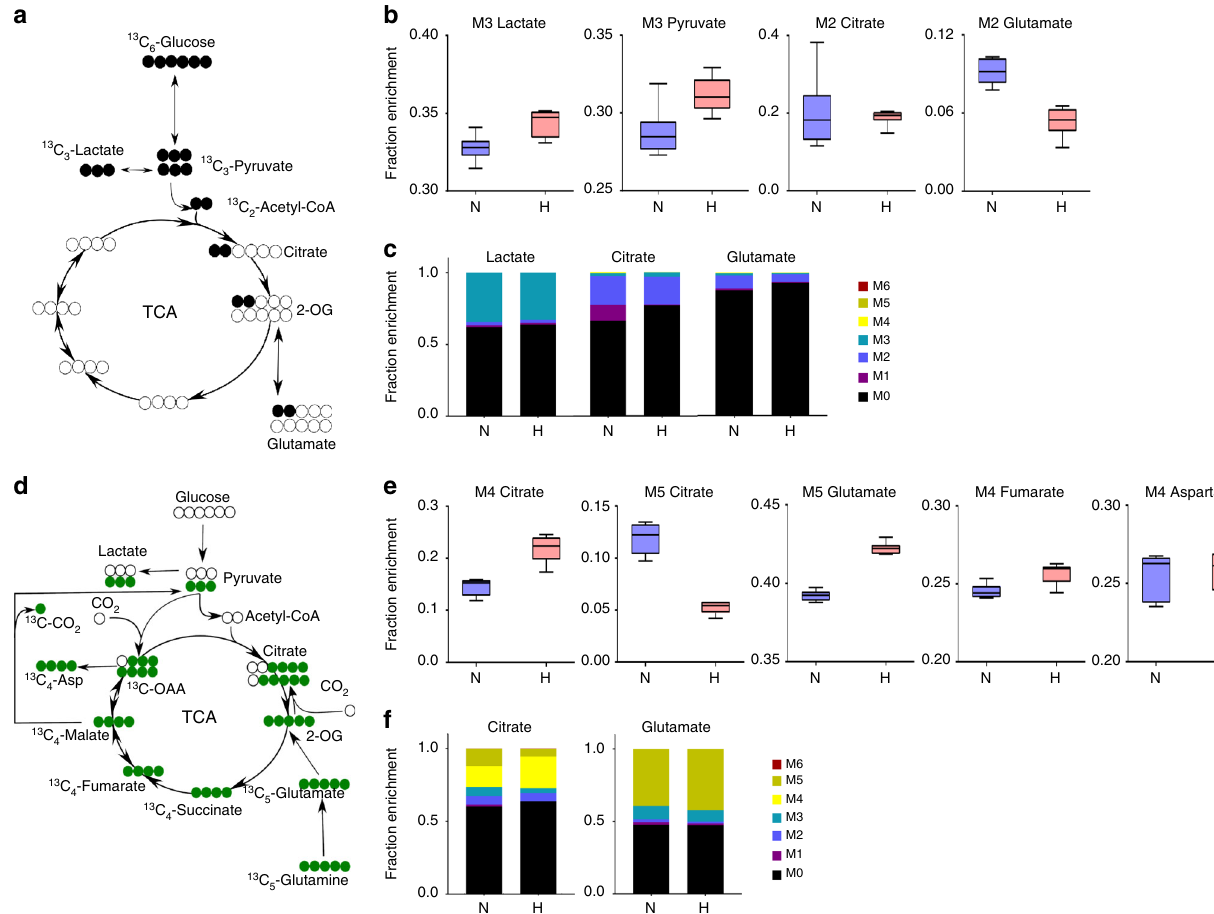
Fig. 2 [ 13 C 6 ]Glucose and [ 13 C 5 ]glutamine labeling of retinal endothelial cells in culture. In response to hyperoxia, [ 13 C 6 ]Glucose and [ 13 C 5 ]glutamine labeling of retinal endothelial cells in culture demonstrates no change in pyruvate to citrate fl ux, (a net decrease in glutamate production from glycolytic carbon, increased glutaminolytic fl ux feeding into TCAC via oxidative decarboxylation route, and decreased malic enzyme fl ux. Retinal endothelial cells were cultivated in [ 13 C 6 ]glucose containing media for 24 h to reach isotopic steady state, following which they were either incubated further in normoxia (21% O 2 ) or hyperoxia (75% O 2 ) for 24 h. a Schematic of the fi rst round of [ 13 C 6 ]glucose carbon atom transition through glycolysis and TCAC. b Fractional enrichment of 13 C-labeled metabolites after 24 h of hyperoxic treatment ( n = 6, t- test p values: M3 lactate = 0.0086; M3 pyruvate = 0.0138; M2 citrate = 0.7974; M2 glutamate< 0.0001). c Comparison of mass isotopomer distributions of lactate, citrate and glutamate between normoxia and hyperoxia. d REC cells were cultivated in [ 13 C 5 ]glutamine containing media for 24 h to reach isotopic steady state, following which they were either incubated further in normoxia (21% O 2 ) or hyperoxia (75% O 2 ) for 24 h. e Fractional enrichment of 13 C-labeled metabolites after 24 h of hyperoxic treatment ( n = 6, t- test p values: M4 citrate = 0.0002; M5 citrate < 0.0001; M5 glutamate< 0.0001; M4 fumarate = 0.0070; M4 aspartate = 0.7713). f Comparison of mass isotopomer distributions of citrate and glutamate between normoxia and hyperoxia. N normoxia, H